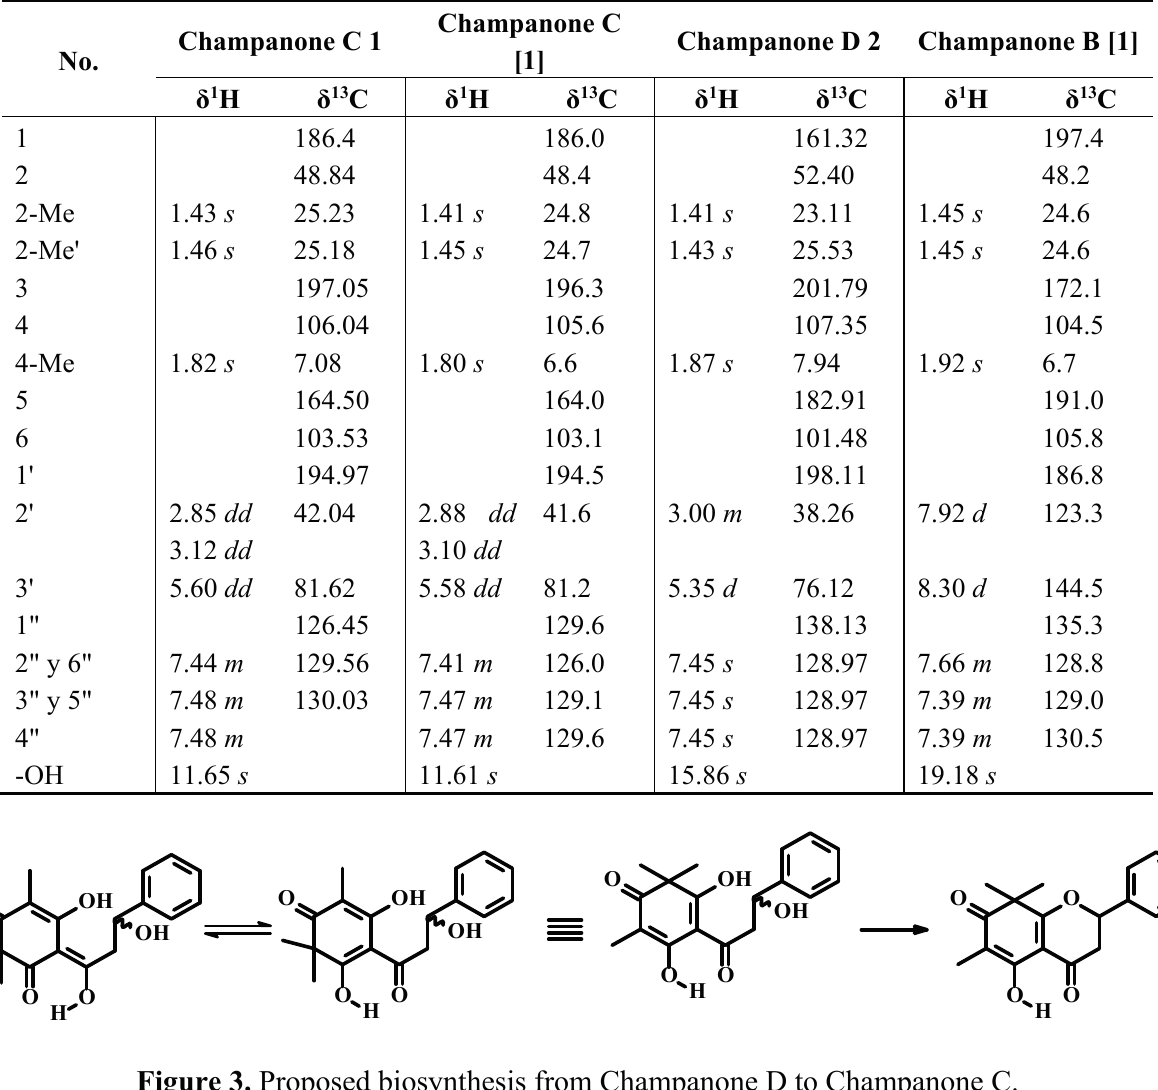
Table 1. 1 H and 13 C-NMR (CDCl 3 ) of several champanones, including champanone D 2 .